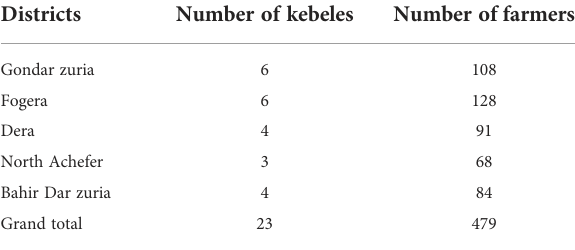
TABLE 2 Number of kebeles and respondent households used for the population count. Districts Number of